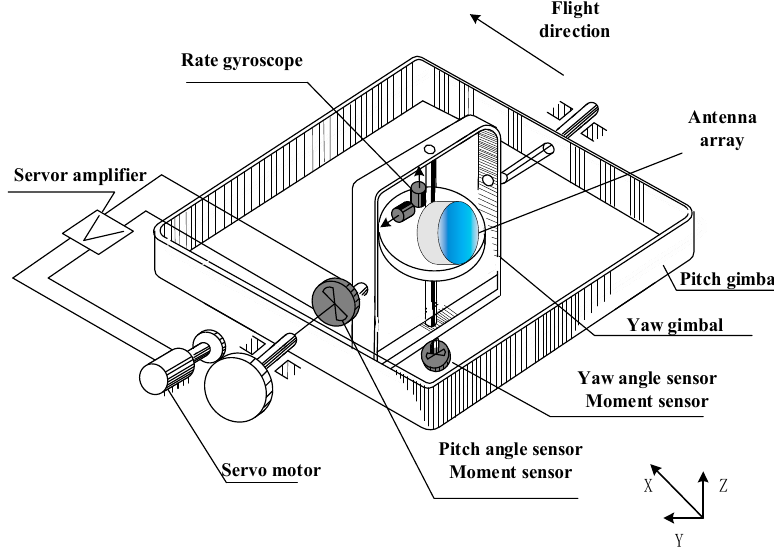
Figure 1. Schematic diagram of the two-axis radar seeker servo system with platform (RSSSP).